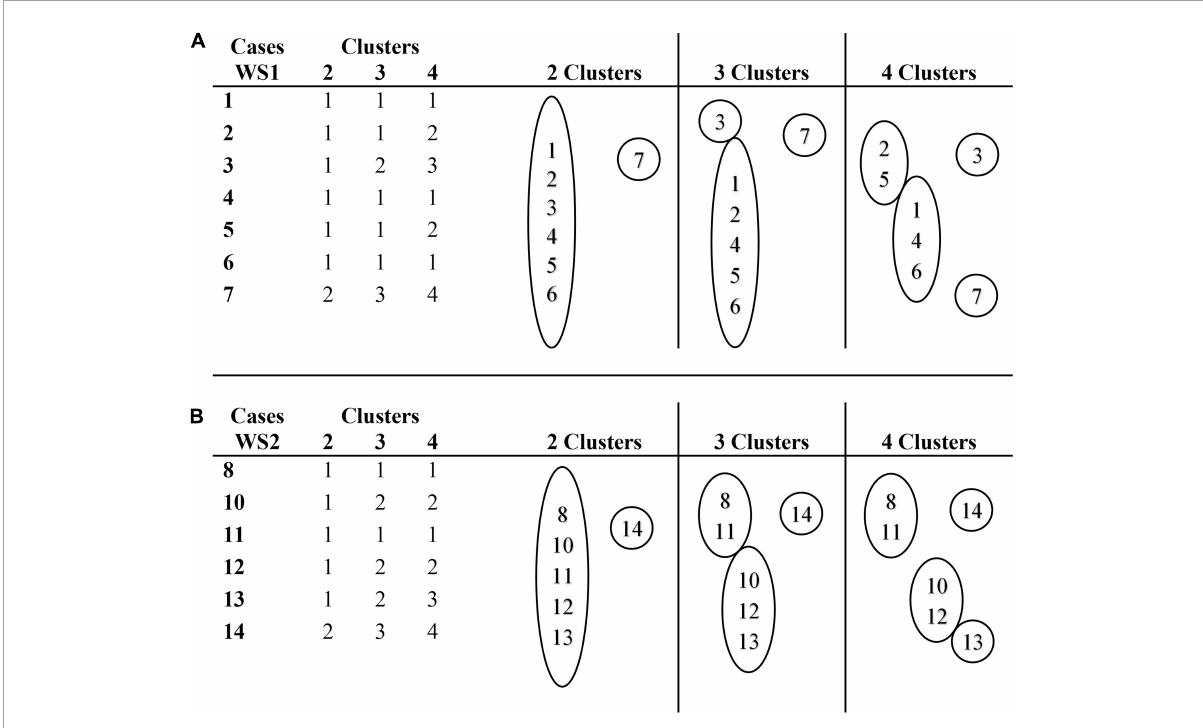
FIGURE8 Cluster membership for a range of solutions (2, 3, and 4 clusters) for omission processes. (A) Cluster membership of cases in WS1 group. (B) Cluster membership of cases in WS2